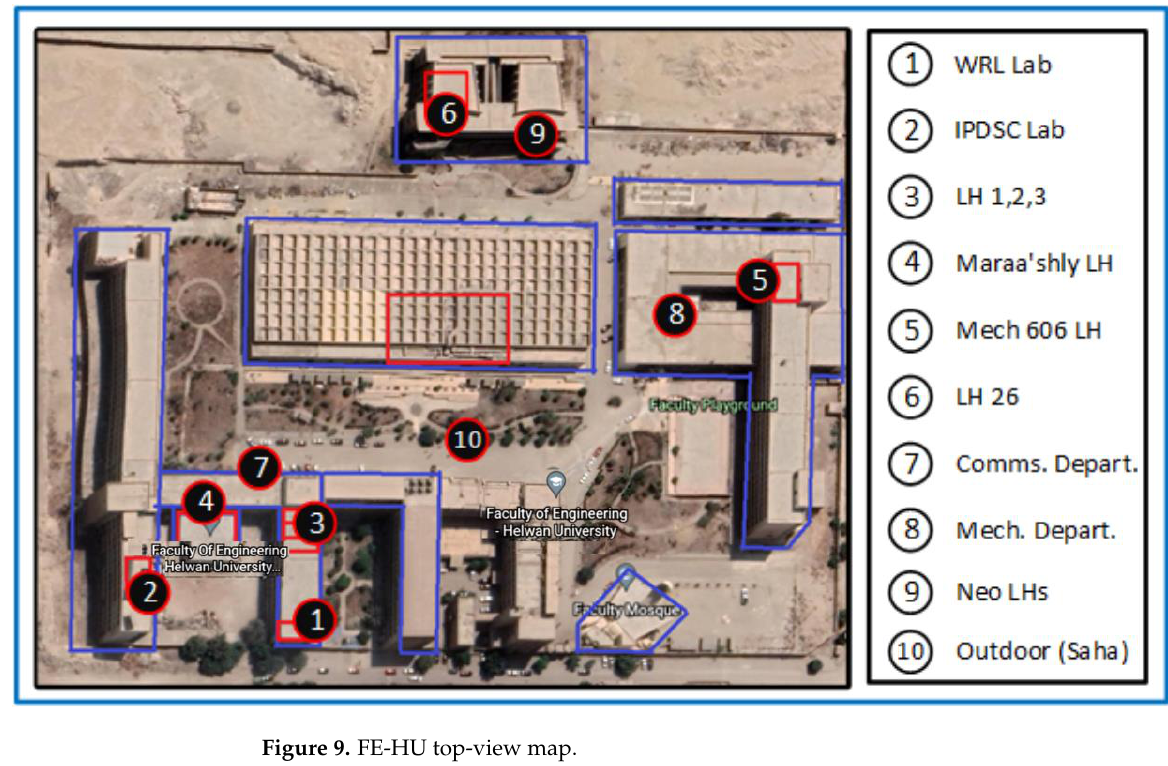
Figure 9. FE-HU top-view map.